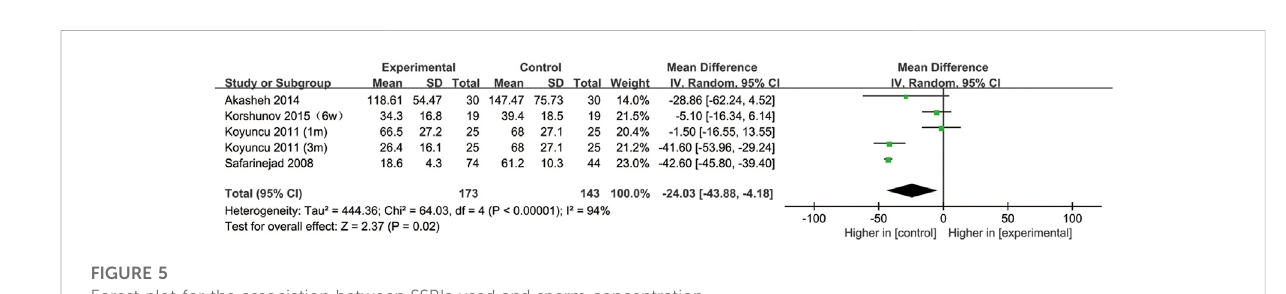
Forest plot for the association between SSRIs used and sperm